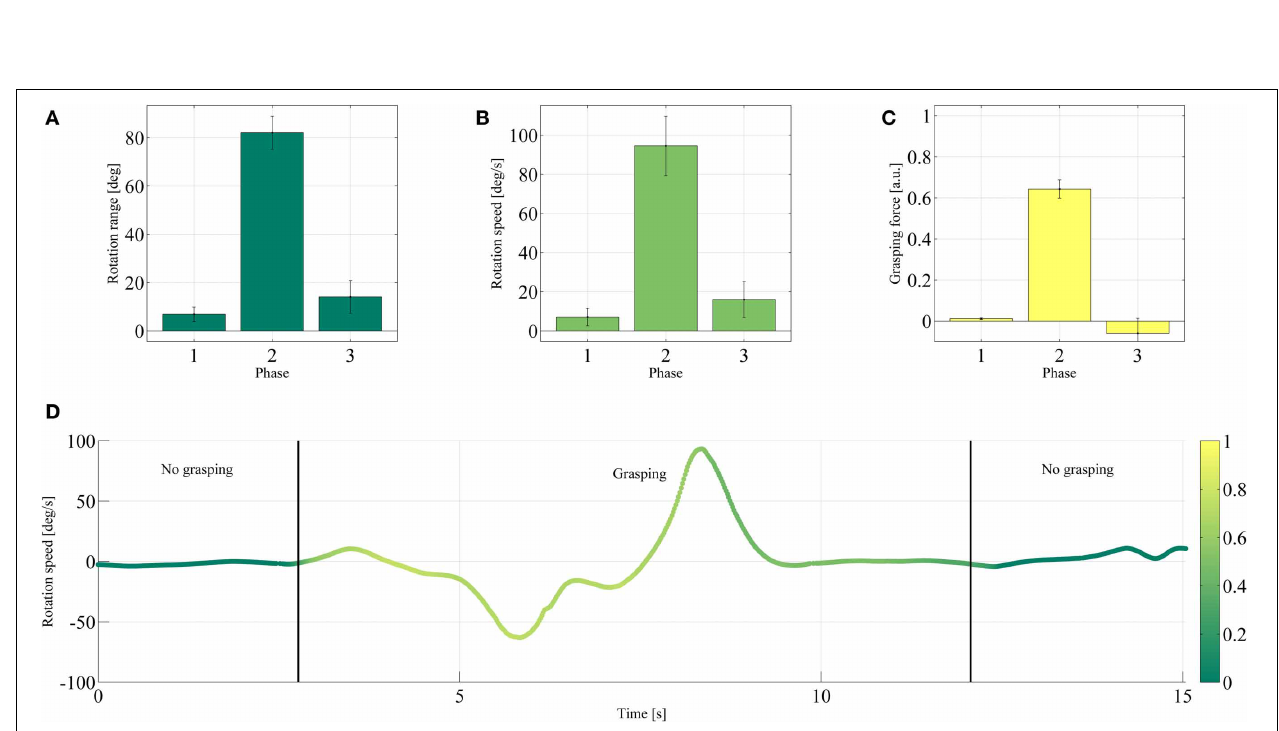
successful trials. (D) Motion speed during one typical trial. The color denotes the grasping force in arbitrary units, according to the color bar on the right-hand side.